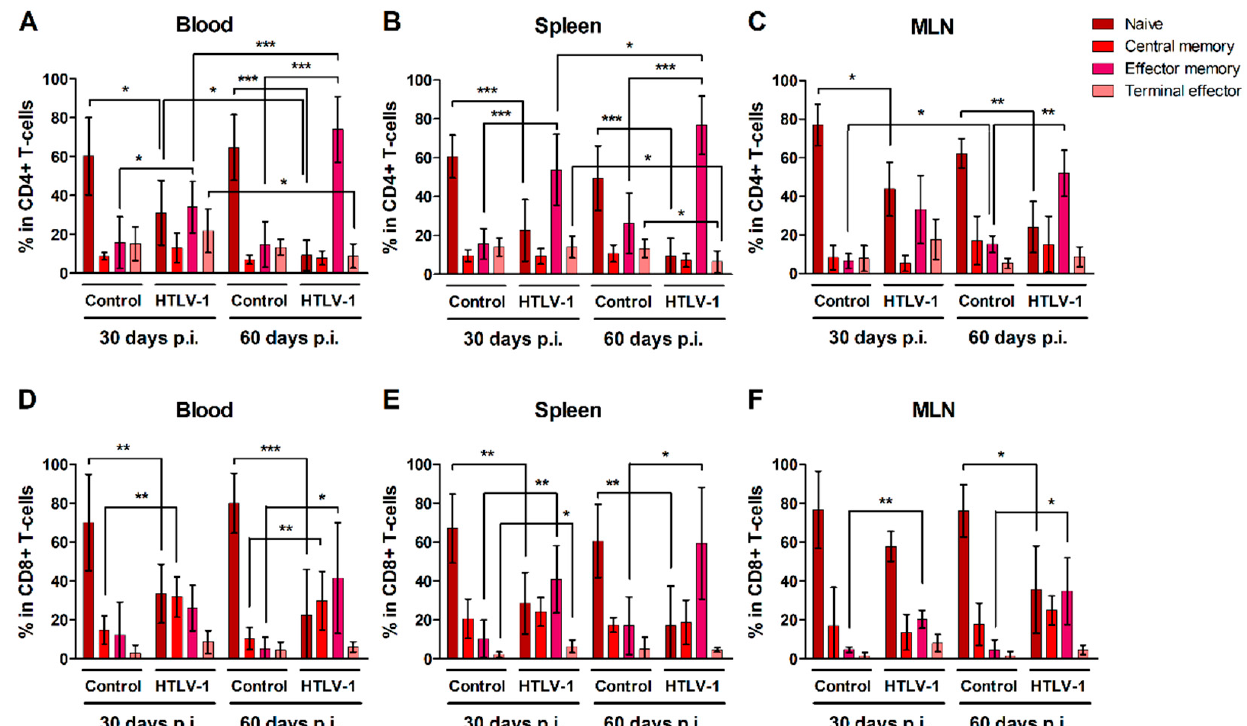
Figure 3. Maturation of CD4 + and CD8+ T-cells in HTLV-1-infected HIS-NSG mice. HTLV-1-infected and mock-infected (control) HIS-NSG mice were euthanized at 30 days and 60 days post-inoculation (p.i.). Blood, spleen, and mesenteric lymph nodes (MLN) were collected and cells were stained for flow cytometry analysis. ( A – C ) CD4 + and ( D – F ) CD8 + T-cell subsets were defined according to the gating strategy shown in the additional file: Figure S2: Naïve (CD45RA + CCR7 + ); central memory (CD45RA − CCR7 + ); effector memory (CD45RA − CCR7 − ); and terminal effector (CD45RA + CCR7 − ) cells. Results are shown as mean percentage with standard deviation bars. The statistical analysis was performed with Student’s t -test by pairwise comparisons, and adjusted p -values were selected when equal variances were not assumed by Levene’s test (*, p < 0.05; **, p < 0.01; ***, p < 0.001). Control groups 30 d and 60 d: n = 7; HTLV-1-infected group 30 d: n = 8; HTLV-1-infected group 60 d: n = 6.